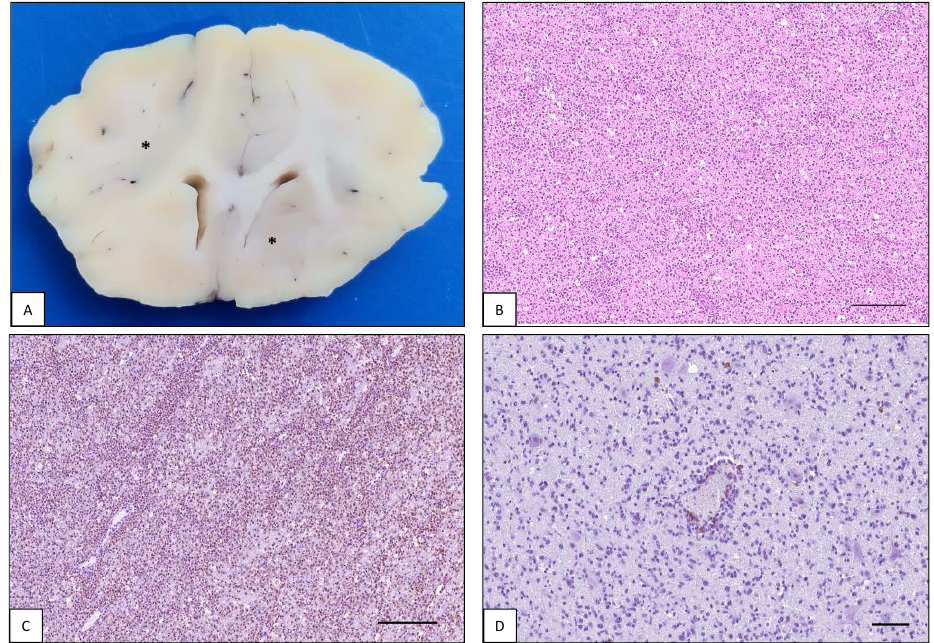
Figure 2. Intracranial lymphoma: lymphomatosis cerebri. Dog brain, case #39. ( A ) Dog brain section at the level of septal and basal nuclei. Bilaterally, large areas of the corona radiata and basal nuclei are grayish discolored (asterisks). The gray to white matter interface is also diffusely blurred. ( B ) Malignant cells diffusely infiltrate the neuroparenchyma (H&E, bar = 250 µm). ( C ) Neoplastic cells are immunoreactive with anti-CD3 antibody (IHC, bar = 250 µm). ( D ) Only a few perivascular and scattered lymphocytes within the surrounding neuroparenchyma are labelled with anti-CD20 antibody (IHC, bar = 150 µm).